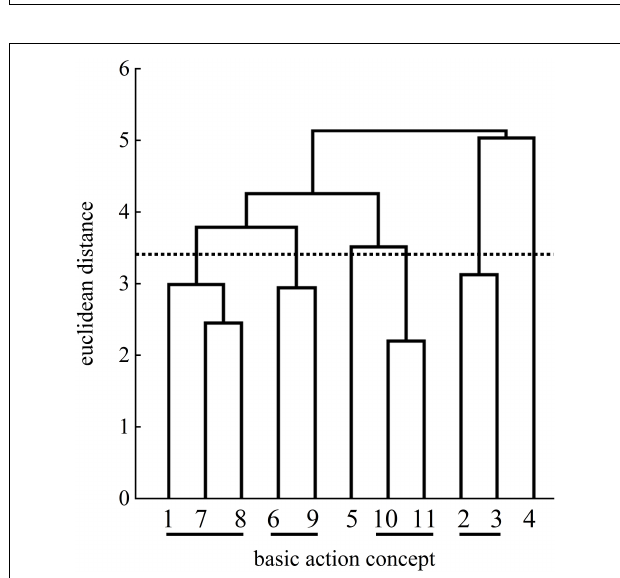
FIGURE 11 | Mean group dendrogram of the control group’s ( n = 14) tennis serves on the